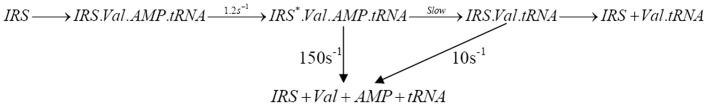
An alternate mechanism of kinetic proofreading (mechanism II) proposed by Fersht.In this mechanism change of enzyme conformation is the slowest step. The overall kinetic involves hydrolysis in two steps.